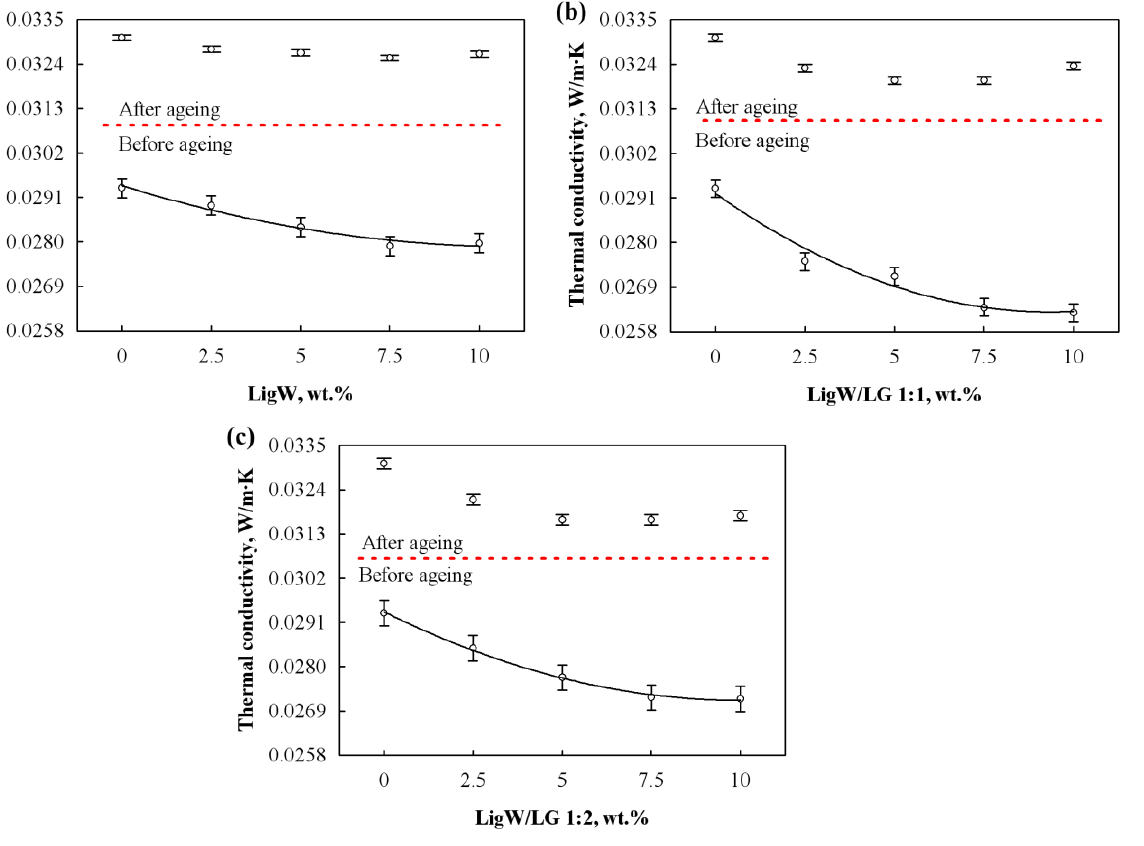
Figure 3. Thermal conductivity before and after ageing of bioPUR foams with: ( a ) LigW particles; ( b ) LigW/LG 1:1 particles; ( c ) LigW/LG 1:2 particles.